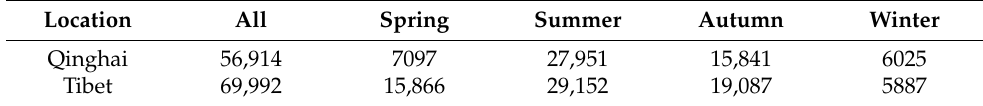
Table 2. Number of tourism microblogs by location and season. Location All Spring Summer Autumn Winter